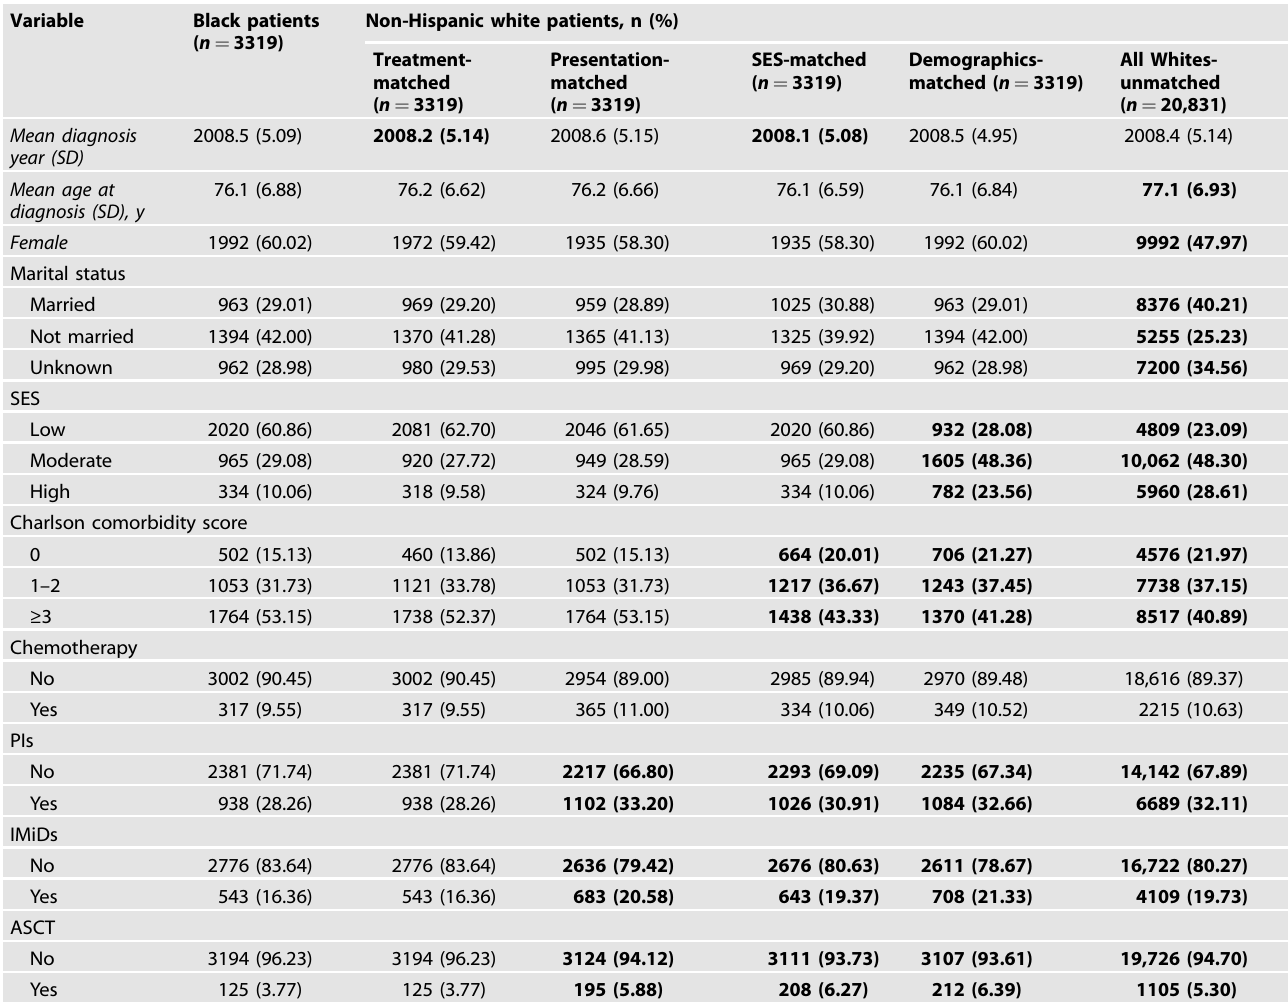
Table 1. Characteristics of non-Hispanic black and non-Hispanic white